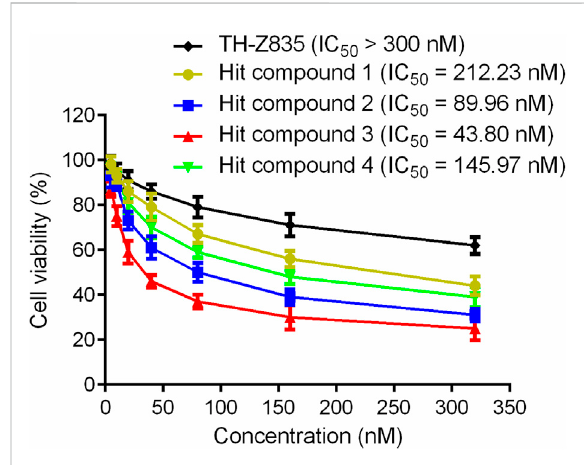
FIGURE 7 Growth inhibition effects of hit compounds 1 – 4 and TH-